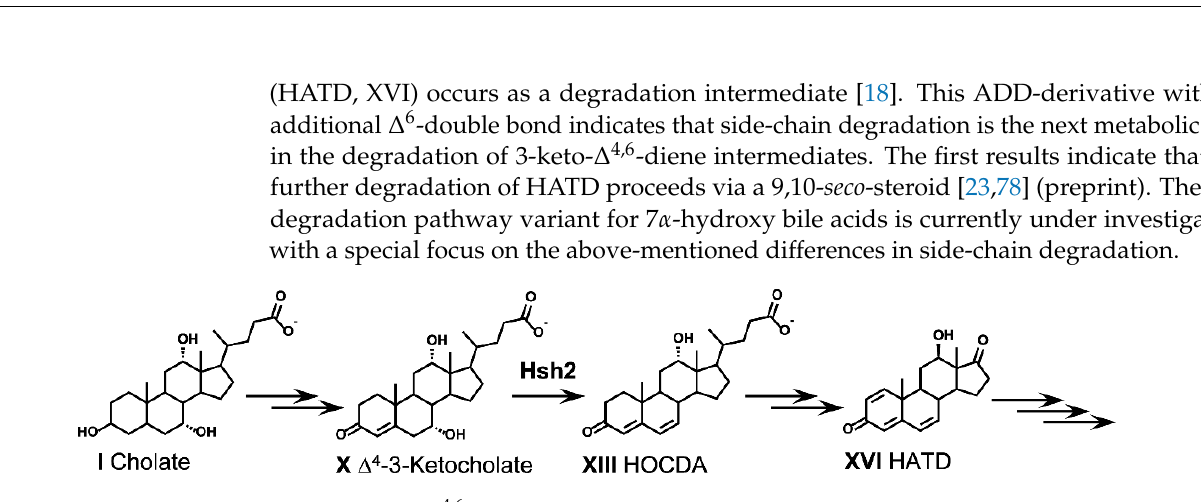
Figure 8. Degradation of bile acids via the ∆ 4,6 -variant of the 9,10- seco pathway as found, e.g., in Sphingobium sp. strain Chol11. For bile acids, the respective deprotonated bile salts are depicted. Abbreviations: HATD, 12 β -Hydroxy-androsta- 1,4,6-triene-3,17-dione.